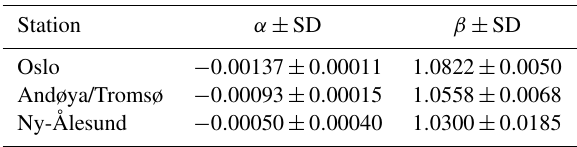
Table 3. Ozone cloud correction for eCLT < 60%, where α is the slope and β is the constant in Eq. (5). The standard deviation (SD) of the coefficients is